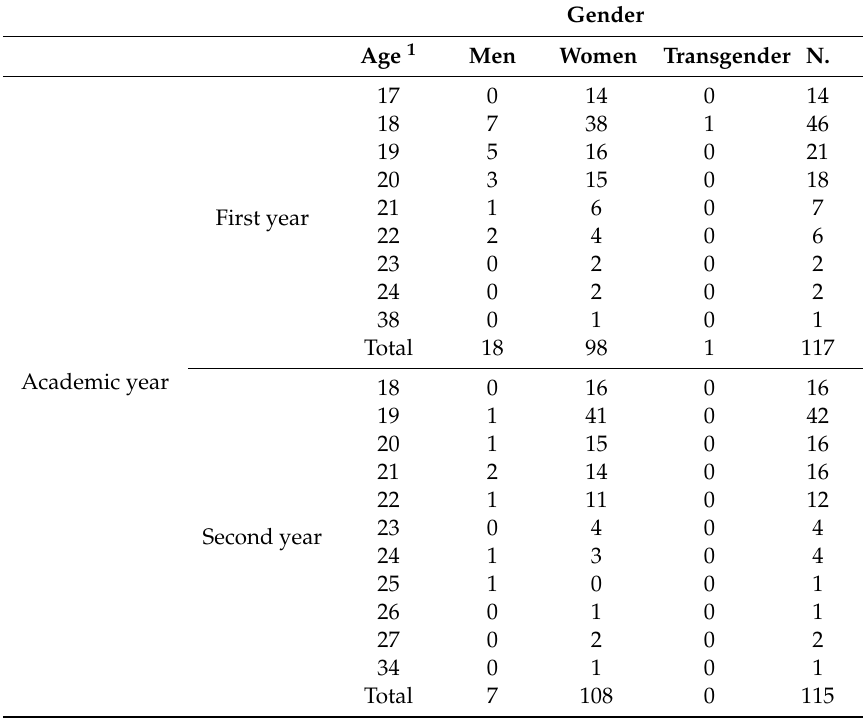
Table 1. Distribution of the sample according to age.